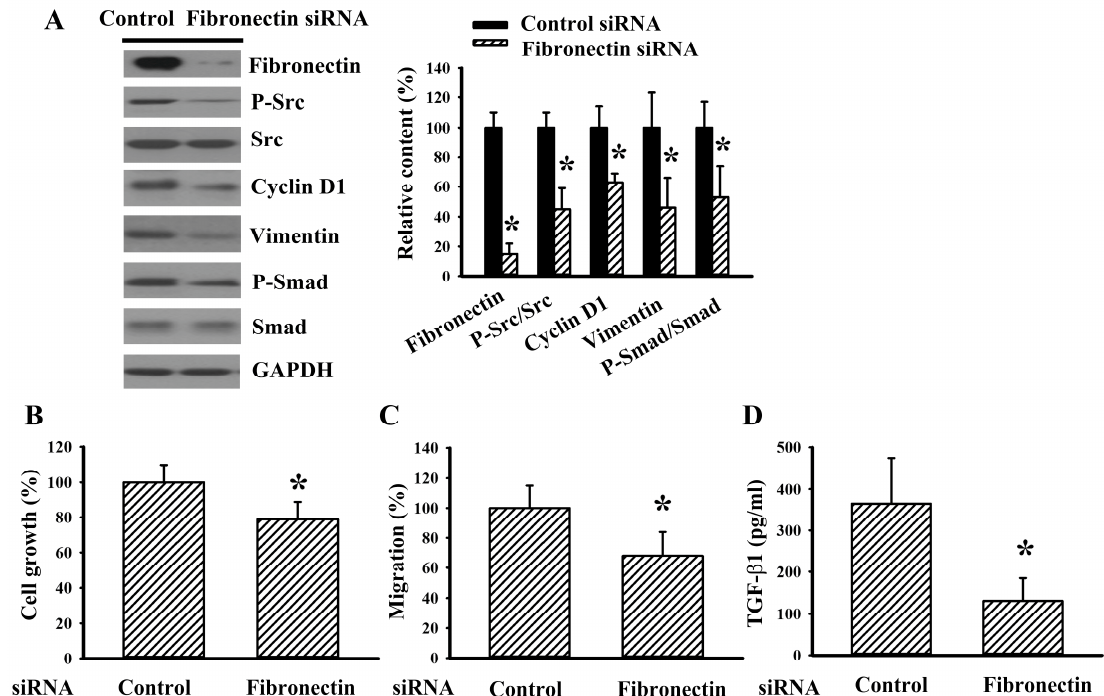
Figure 4. Fibronectin silencing decreased cell growth and migration in Caki-1 cells. Caki-1 cells were transfected with control siRNA and fibronectin siRNA for 48 h. ( A ) Proteins were extracted and subjected to Western blot analysis with indicated antibodies. Representative blots are shown. ( B ) The resultant transfected cells were seeded onto 96-well plates. Twenty-four hours later, cell growth was measured by MTS reduction assay. ( C ) The resultant transfected cells were seeded onto Transwell inserts and subjected to Transwell migration assay for 24 h. The lower chambers were filled with DMEM containing 10% FBS. ( D ) The resultant transfected cells were seeded onto 24-well plates. Twenty-four hours later, the supernatants were collected and subjected to ELISA for the measurement of TGF- β 1. Bar graphs showed quantitative results among groups and the value in control siRNA group was defined as 100% ( A – C ). * p < 0.05 vs control siRNA group, n = 3.